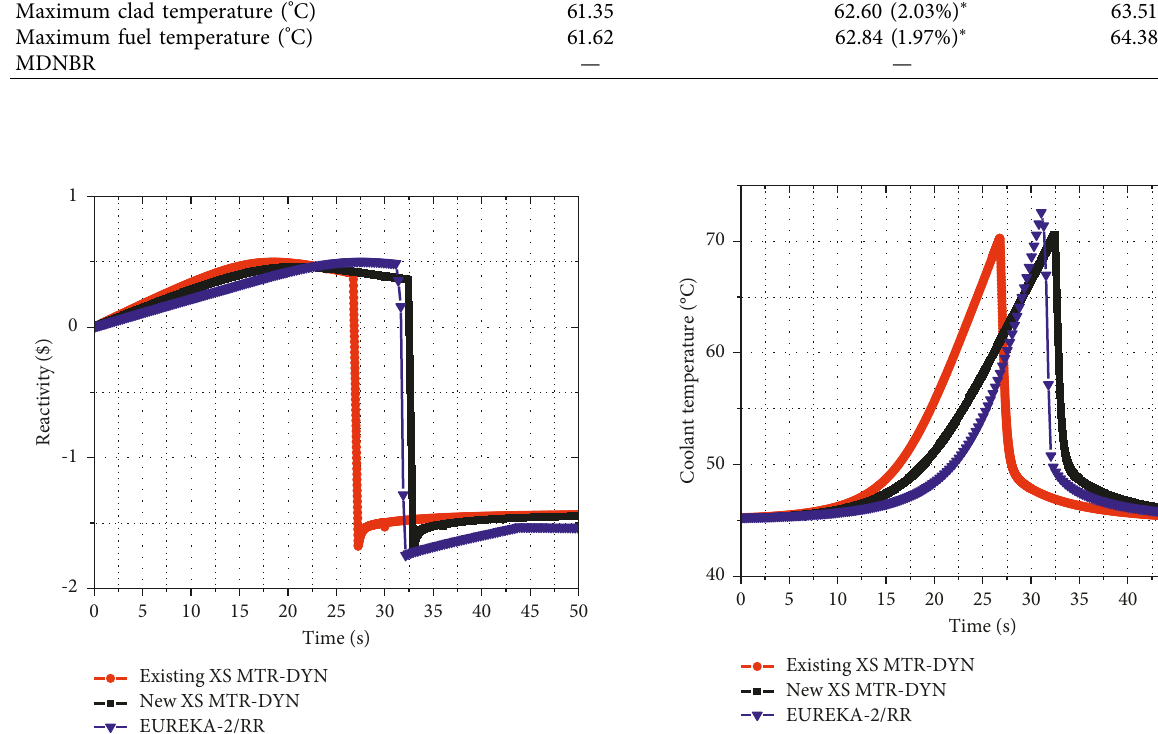
Figure 15: Coolant temperature during RIA transient at initial power of 1MW.